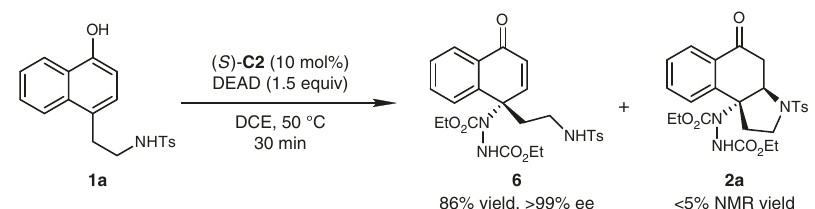
Fig. 4 Isolation of the Intermediate. Reaction conditions: 1a (0.1 mmol), DEAD (0.15 mmol) and ( S )- C2 (10 mol%) in DCE (2 mL) at 50 °C for 30 min